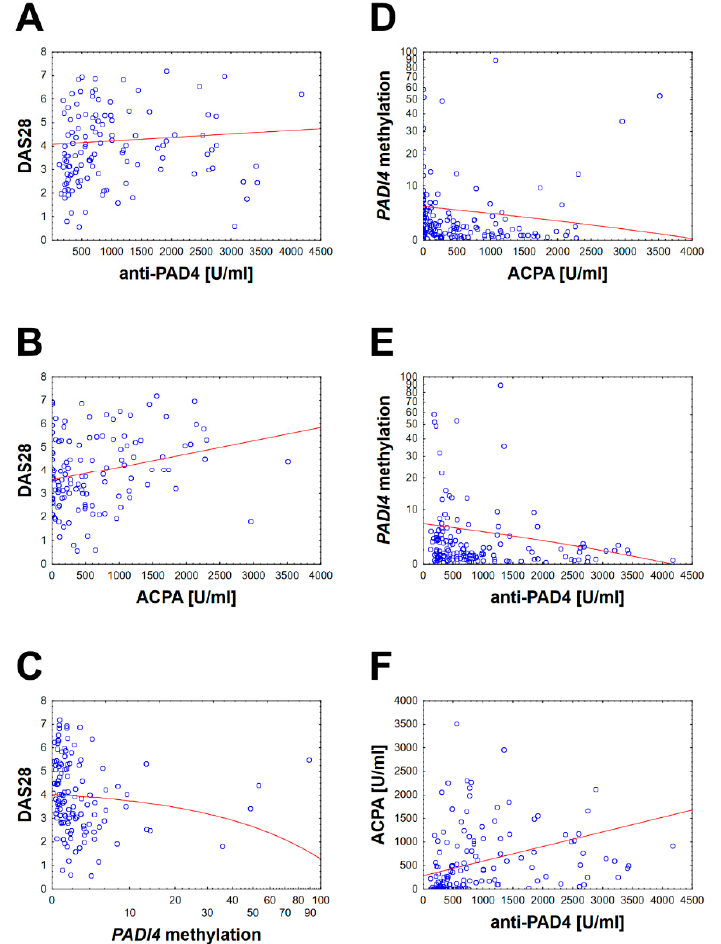
Figure 2. Anti-PAD4 concentration level in RA groups according to DAS28 activity, HC and all RA patients. Results presented as median and interquartile range. (a) p = 0.000018, (b) p = 0.000095, (c) p = 0.038, (d) p = 0.00001. RA moderate vs. Remission p = 0.054, RA low vs. HC p = 0.07. The additional graphical presentations of our results are showed in Supplementary File S7. No differences in the degree of methylation and anti-PAD4 serum level were found between the groups of patients divided according to the treatment used, including the drugs mechanism of action. (Data